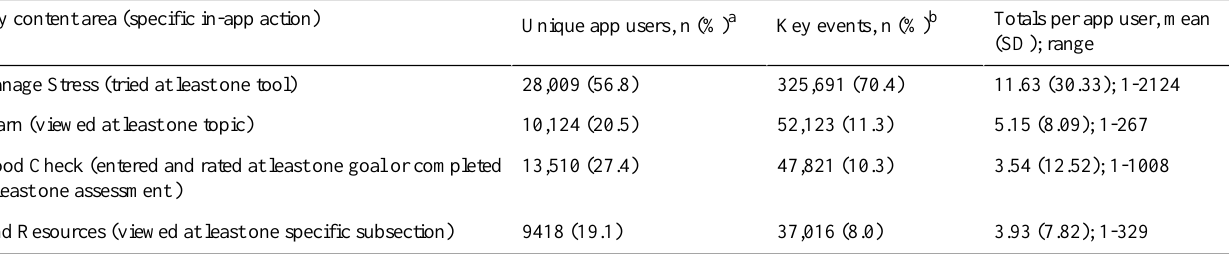
Totals per app user,